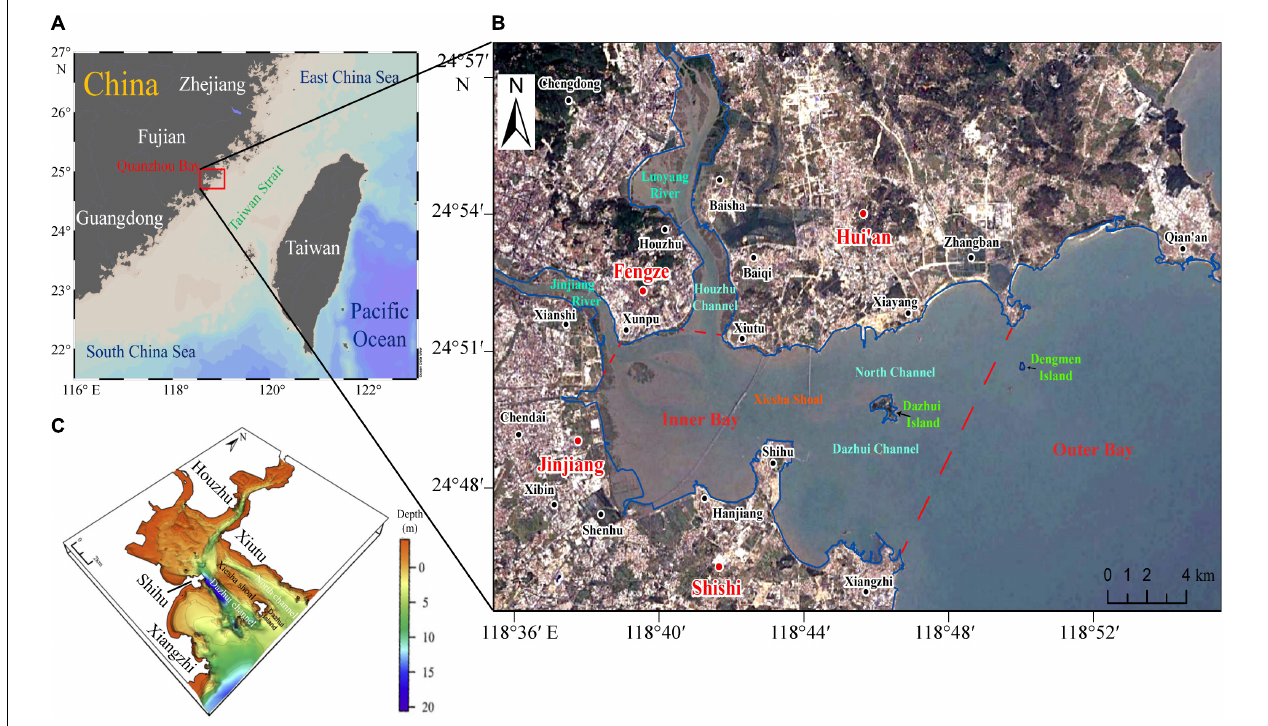
FIGURE 1 | Overview of the study area. (A) The location of the study area (From Ocean Data View); (B) The basic information of Quanzhou Bay, including cities, islands, channels, and rivers (The background image is a satellite image of Quanzhou Bay in 2020 from Google Earth Pro); (C) Landform and topography of Quanzhou Bay (Chen et al.,